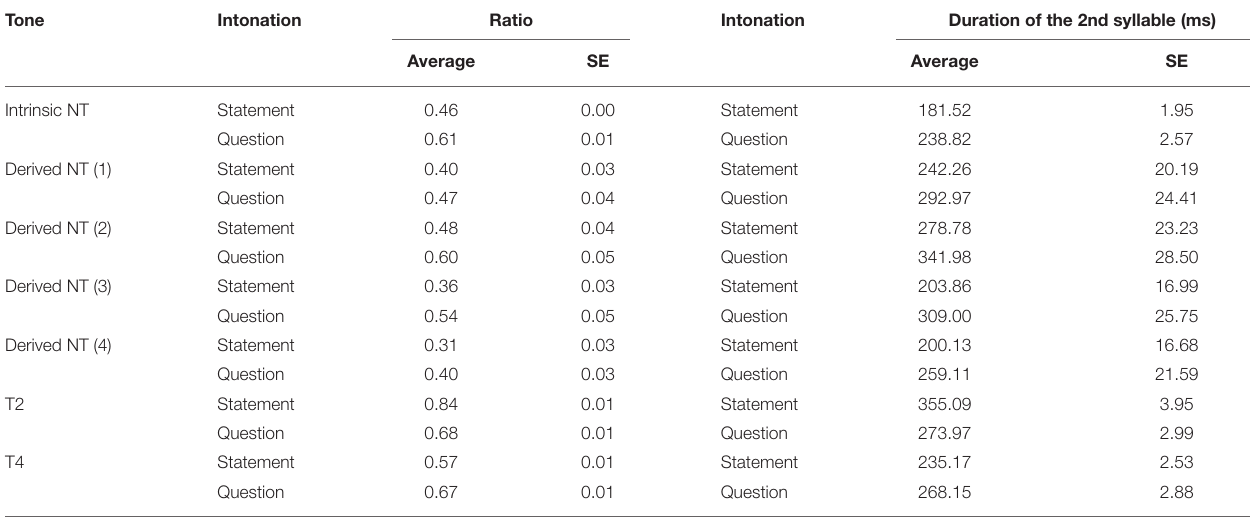
TABLE 3 | Duration ratio and duration of the 2nd syllable by tone and